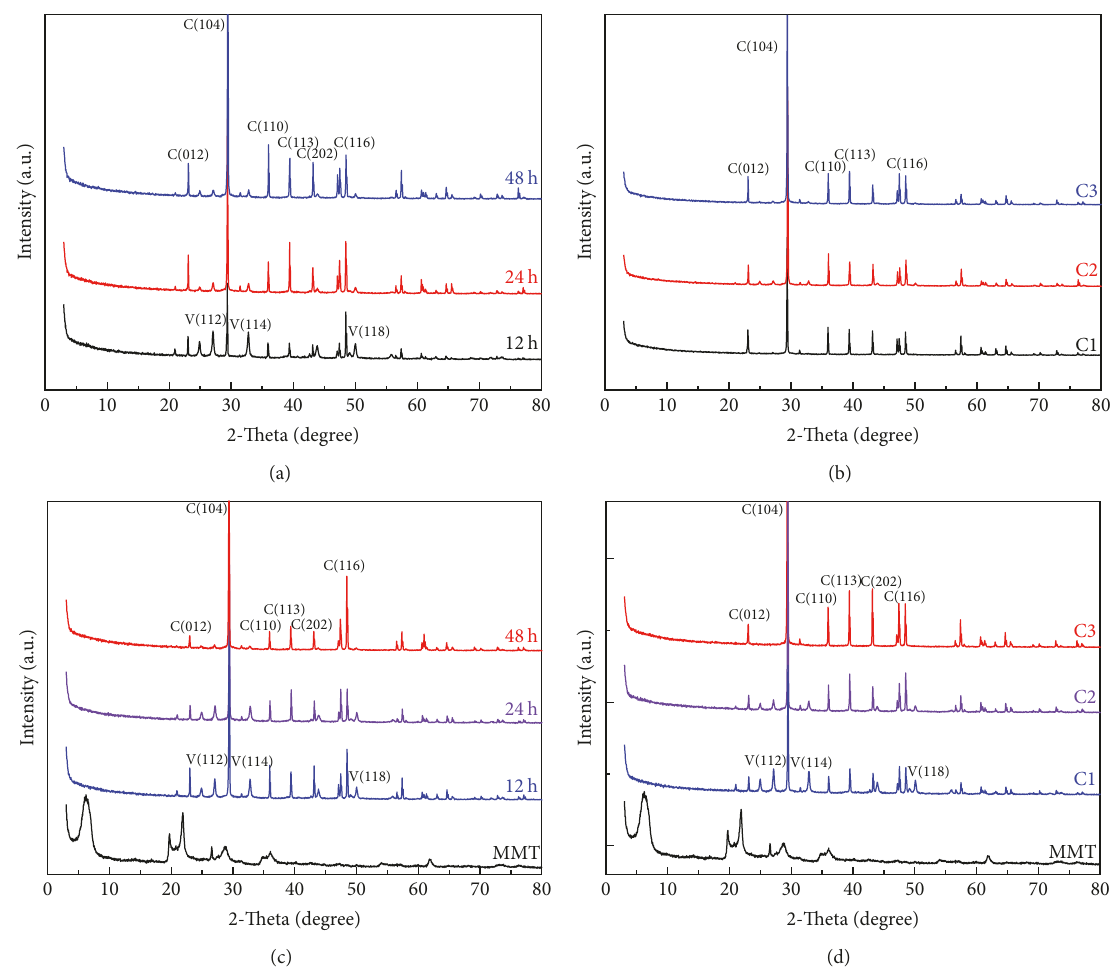
Figure 3: (a) XRD patterns of mineralized samples by different time without MMT, (b) XRD patterns of mineralized samples by different Ca 2+